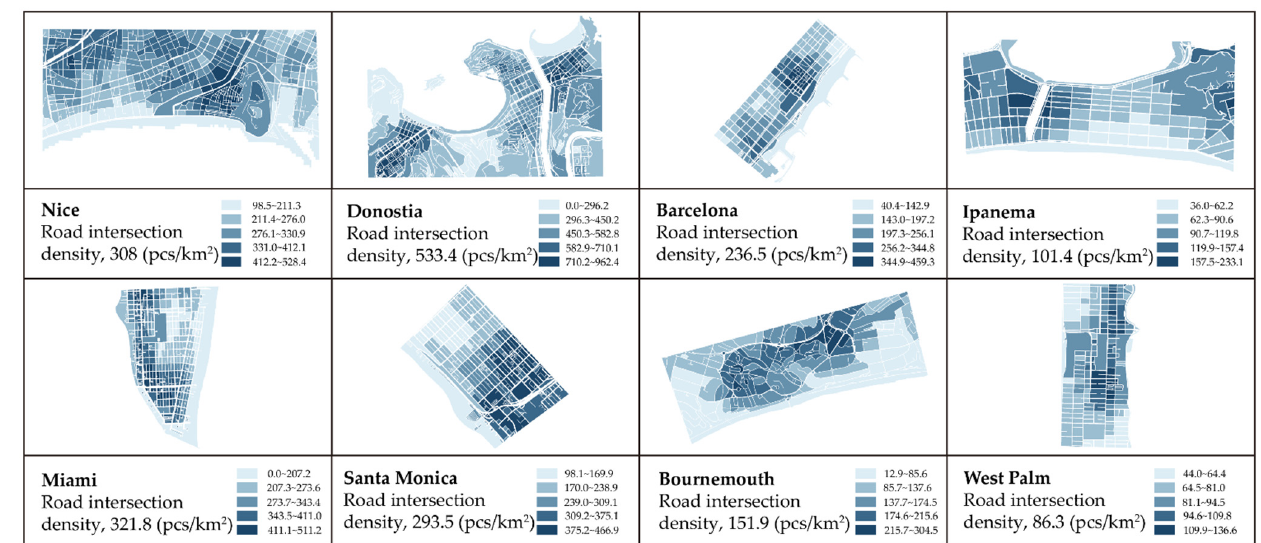
Figure 7. The visualization results of road intersection density in successful coastal cases.